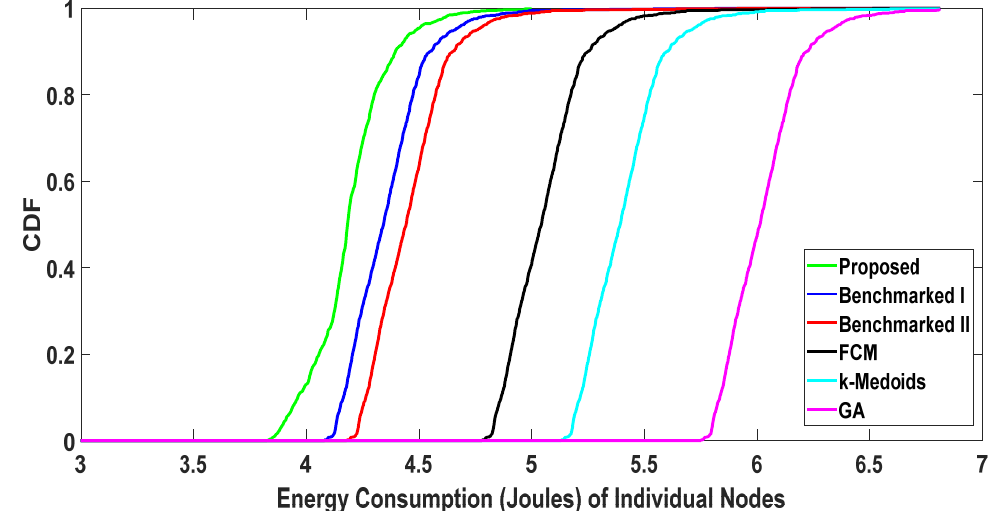
Figure 11. Cumulative Distribution Function (CDF) of energy consumption ( 𝑤 (cid:2869) (cid:3404) 0.4, 𝑤 (cid:2870) (cid:3404) 0.6 ).